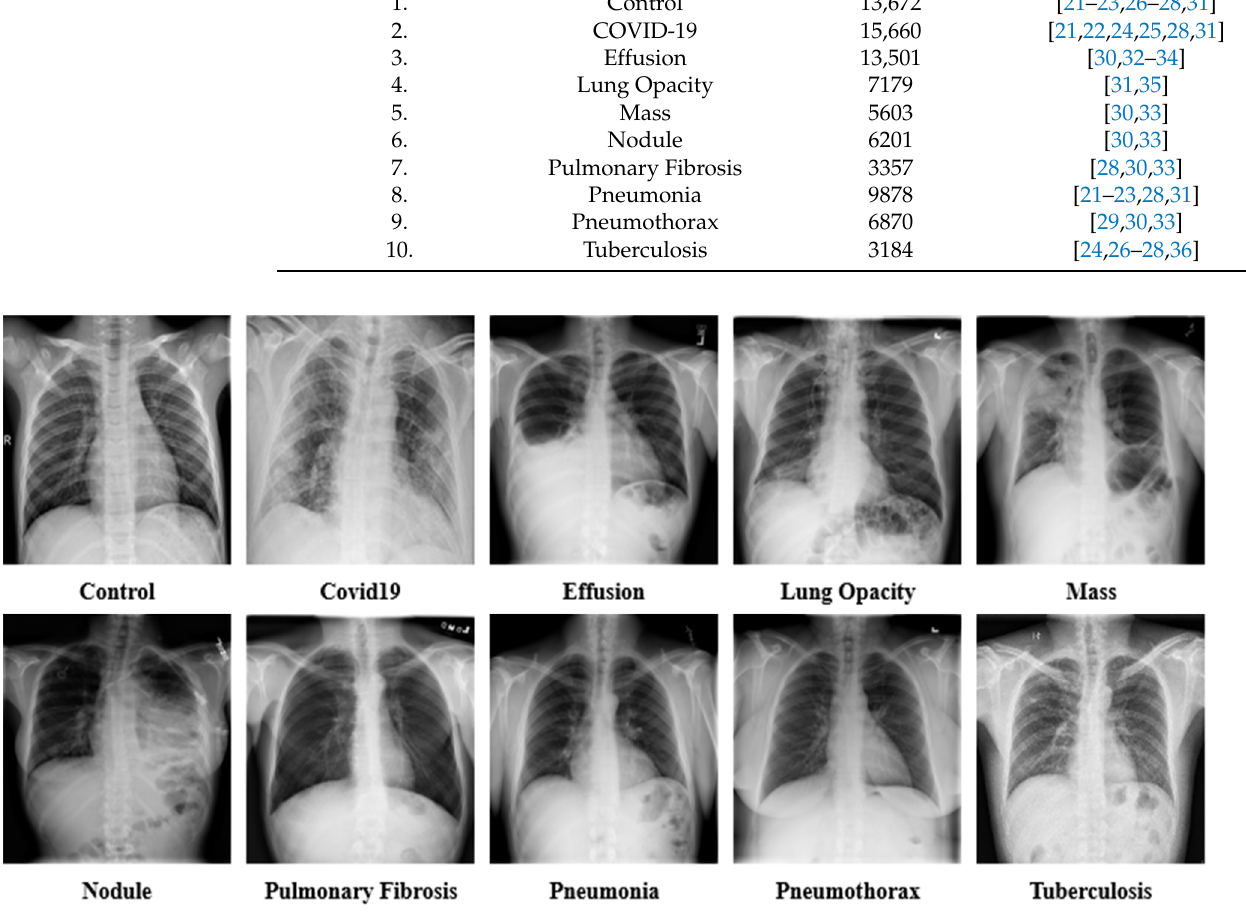
Figure 2. Sample dataset of the ten classes, including Control, COVID-19, Effusion, Lung Opacity, Mass, Nodule, Pulmonary Fibrosis, Pneumonia, Pneumothorax, and